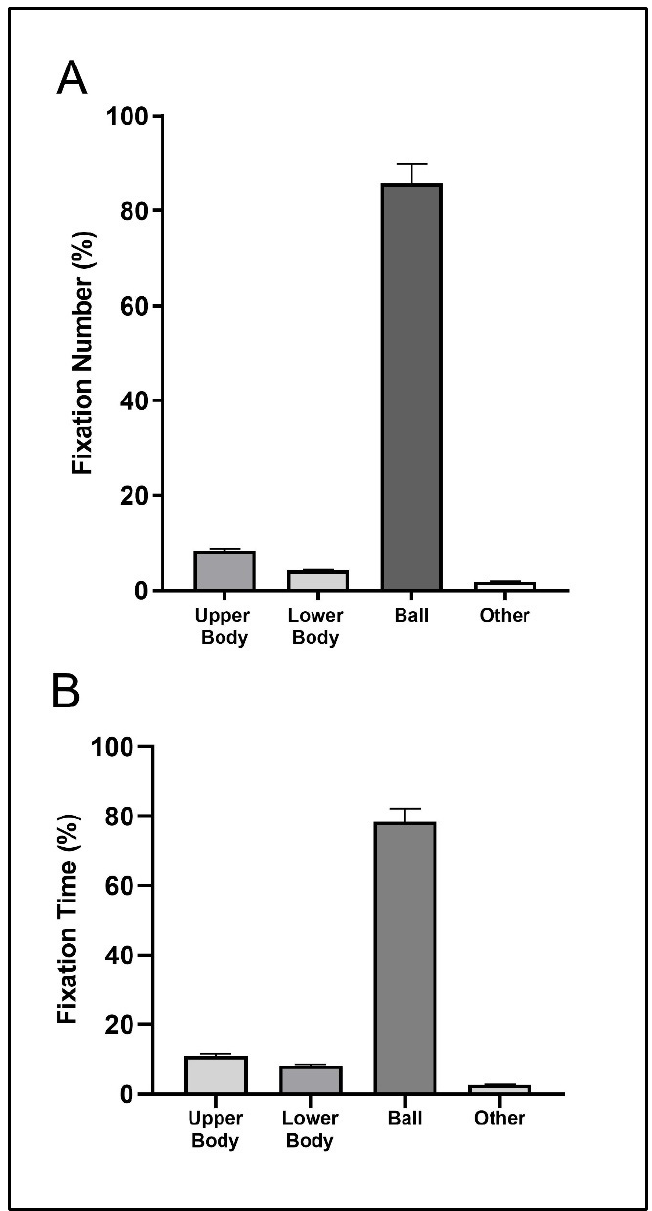
Figure 3. Mean (bar) and standard deviation (error bars with 95% confidence interval) of the relative fixation number ( A ) and fixation time ( B ) for the tray/smash return situation.